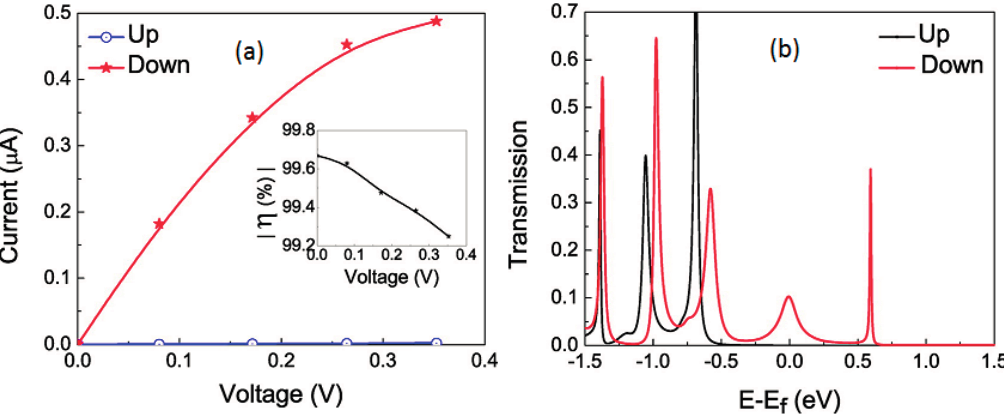
Figure 11. ( a ) Spin dependent current in the F-BNNT/Au junction; the F-coverage is 4.1%. Spin down current is significantly higher than the spin up current. Inset shows the variation of the magnitude of spin injection coefficient ( η ) with bias; the spin injection coefficient is calculated from the spin up and spin down currents as discussed in the text. ( b ) Spin polarized transmission in the F-BNNT/Au junction; the F-coverage is 4.1%; Up and Down refer to majority and minority spin states, respectively. A singe particle Green's function approach in conjunction with density functional theory is used to calculate the spin polarized